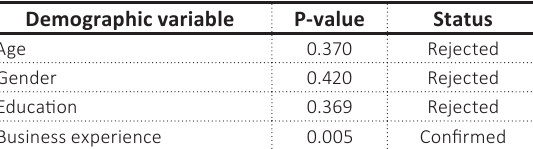
Table 2. Demographic variables and tax